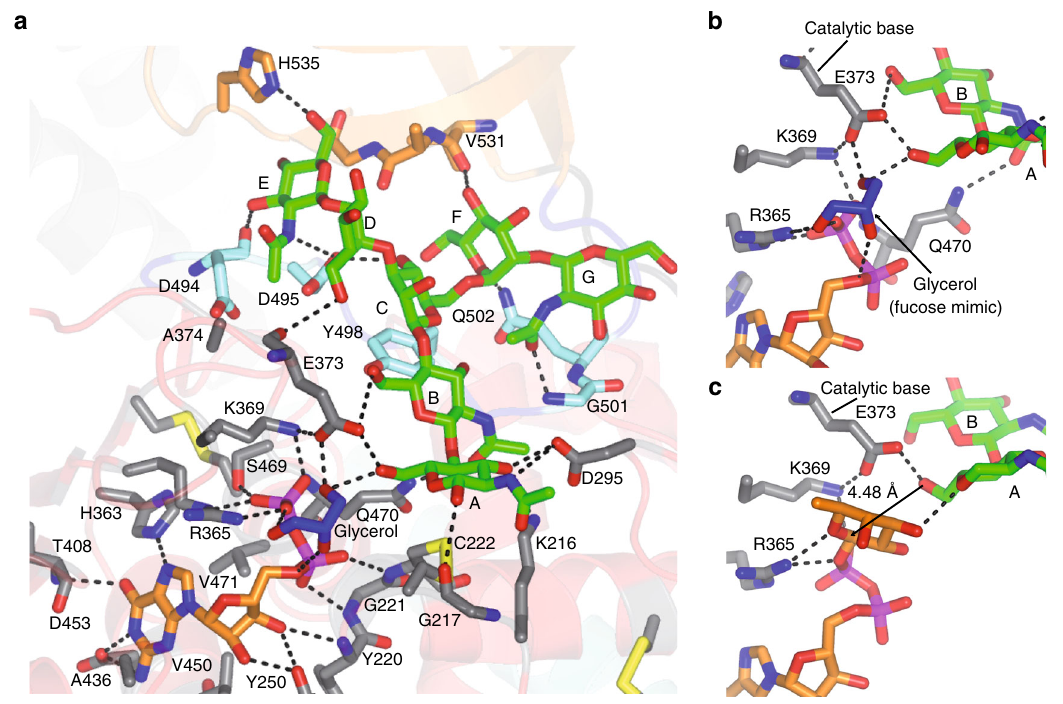
Fig. 5 Structural features of GDP-Fuc and G0 binding sites. a Complete GDP-Fuc and G0 binding sites of the Hs FUT8-GDP- G0 complex. The residues forming the GDP-Fuc/A G0 /B G0 and C G0 /D G0 /E G0 /F G0 /G G0 binding sites are depicted as gray and aquamarine/orange carbon atoms, respectively. GDP, G0 and glycerol are shown as orange, green and blue carbon atoms, respectively. Hydrogen bond interactions are shown as dotted black lines. b , c Close- up view of the binding site region of the Hs FUT8-GDP- G0 and Hs FUT8-GDP-Fuc- G0 complexes showing the essential residues (Arg365, Lys369 and Glu373) that are major players in the plausible S N 2 single-displacement reaction mechanism. Note the proximity and the orientation of the A G0 OH6 to the anomeric carbon (4.48 Å) which is compatible with the inversion of the con fi guration during the reaction.